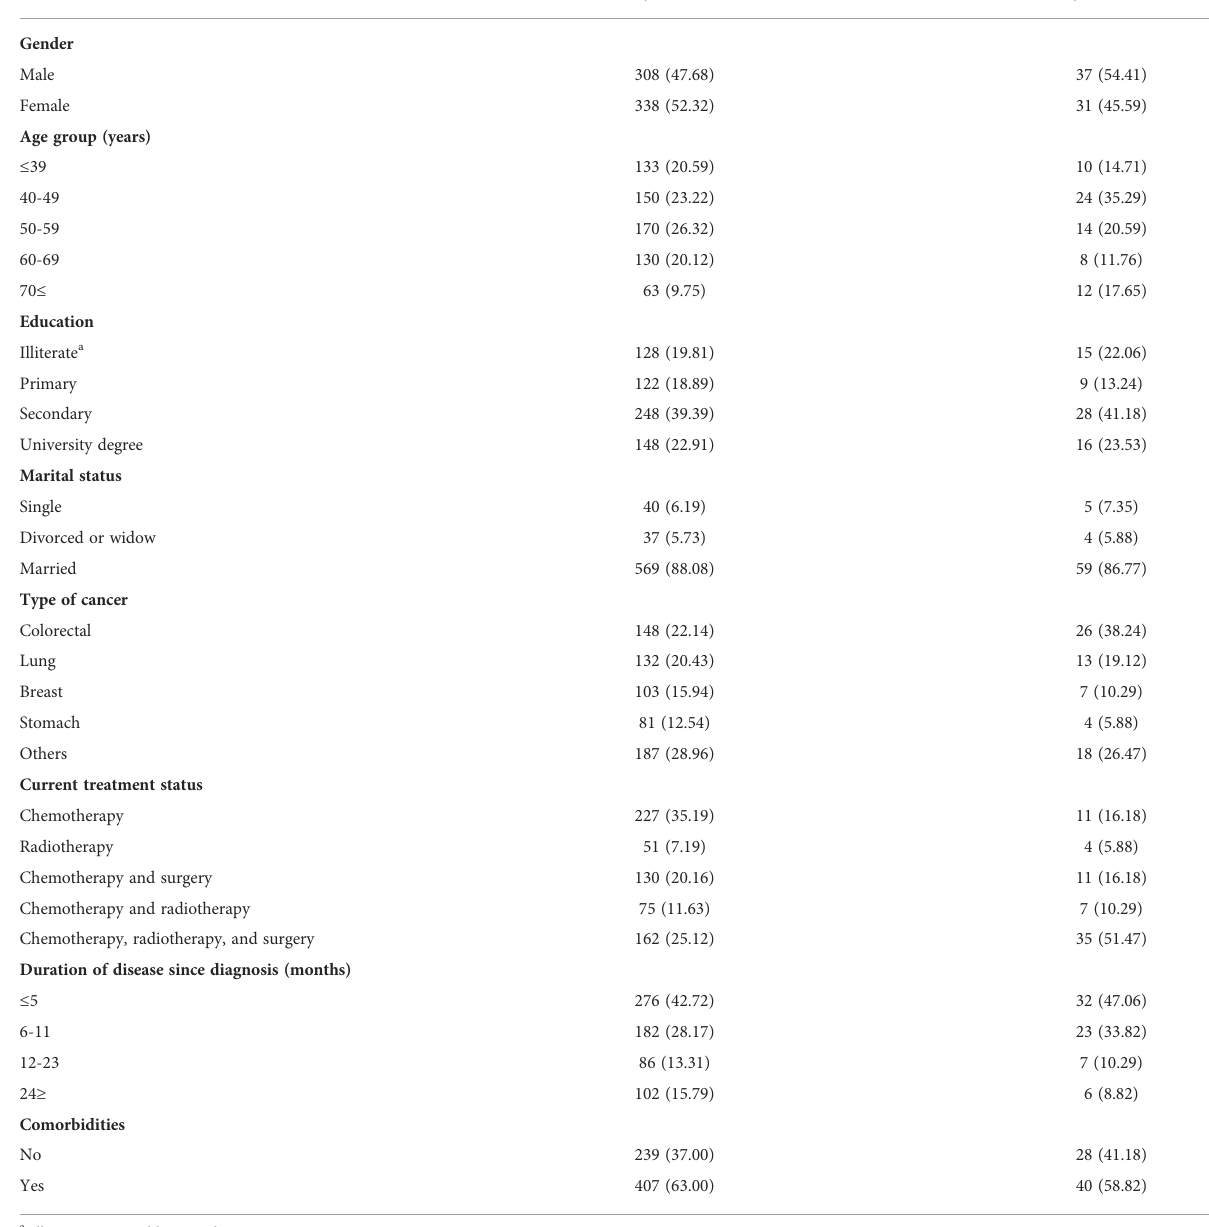
TABLE 1 Patients ’ characteristics in the surveys.